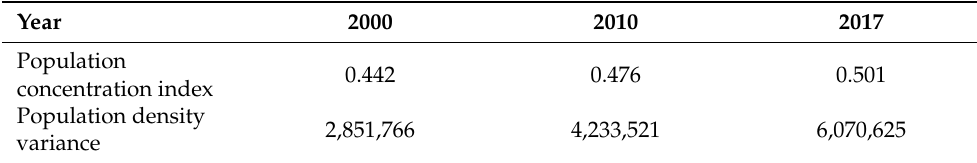
Table 2. Population distribution indexes in the Beijing–Tianjin–Hebei region.